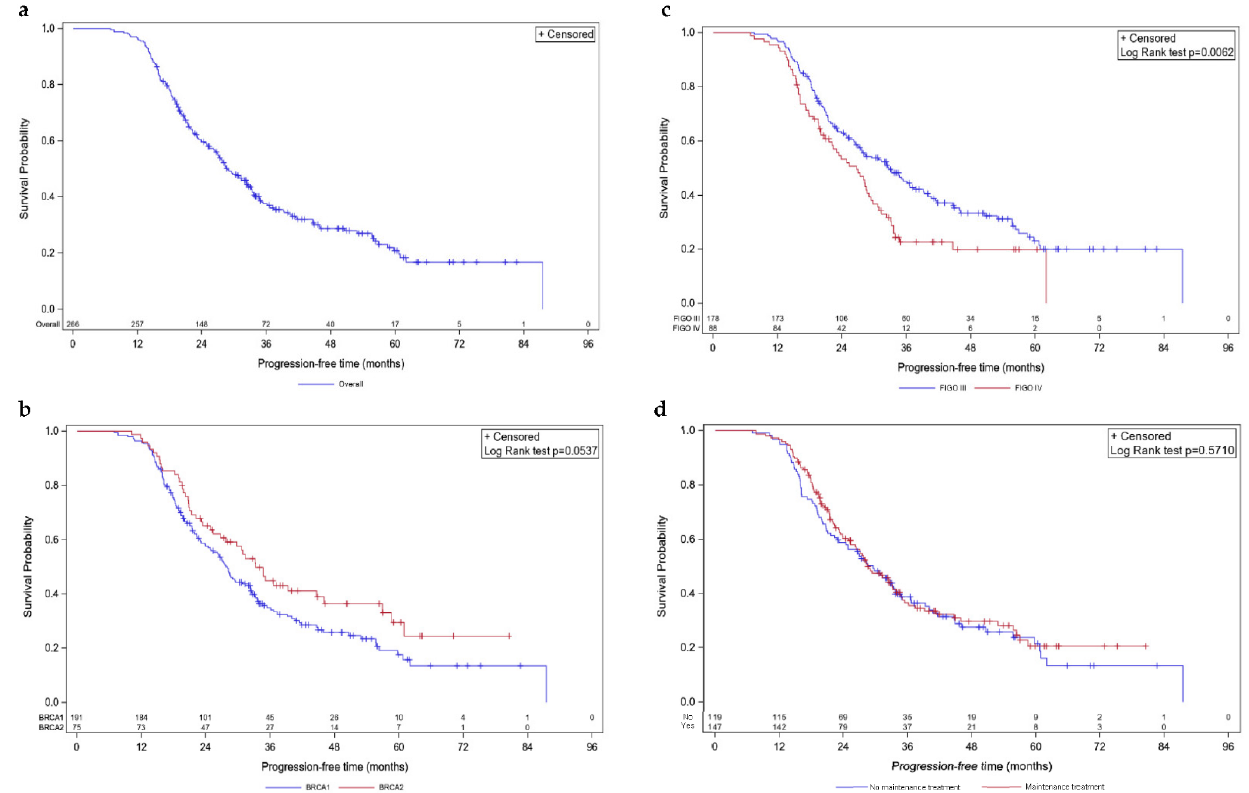
Figure 1. Kaplan–Meier progression-free survivals. Survival curves are given for overall population ( a ) and stratified according to mutated BRCA1 vs. BRCA2 ( b ), FIGO III vs. IV ( c ), and maintenance vs. no maintenance treatment ( d ).